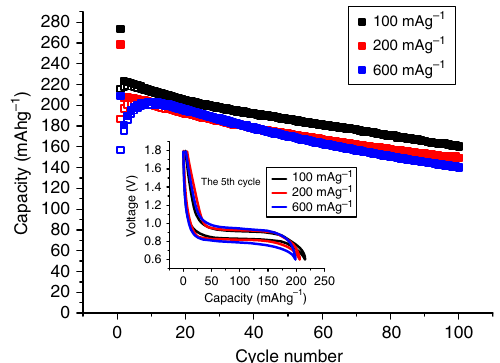
Figure 4 | Variation of capacity with cycle number for Li(V 0.5 Ti 0.5 )S 2 . Closed squares correspond to intercalation and open squares to deintercalation. Inset shows load curves as a function of rate on the 5th cycle.